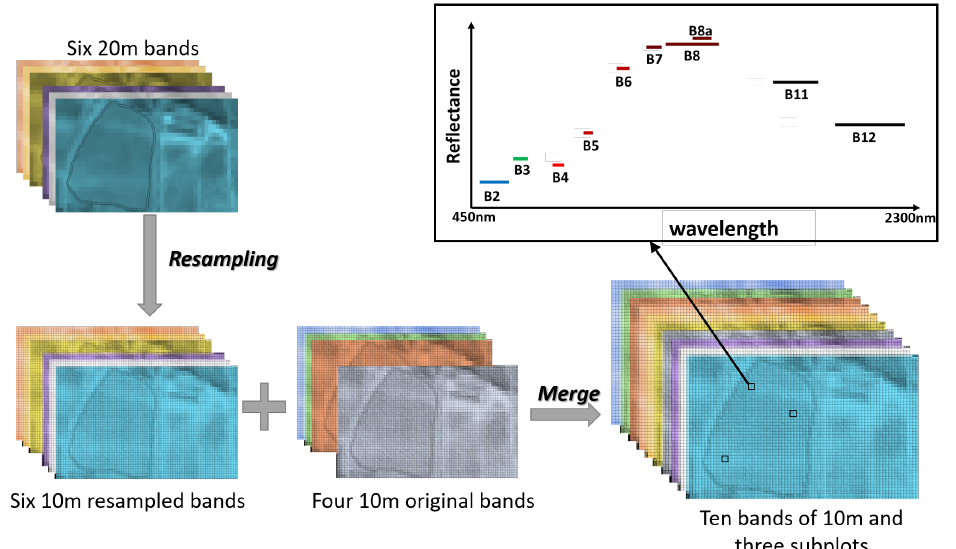
Figure 5. Flowchart of the resampling and the merge of S2 bands used in this study. Example for an image with only one vine plot with three subplots. This method as been used for the 38 images and the 103 subplot.